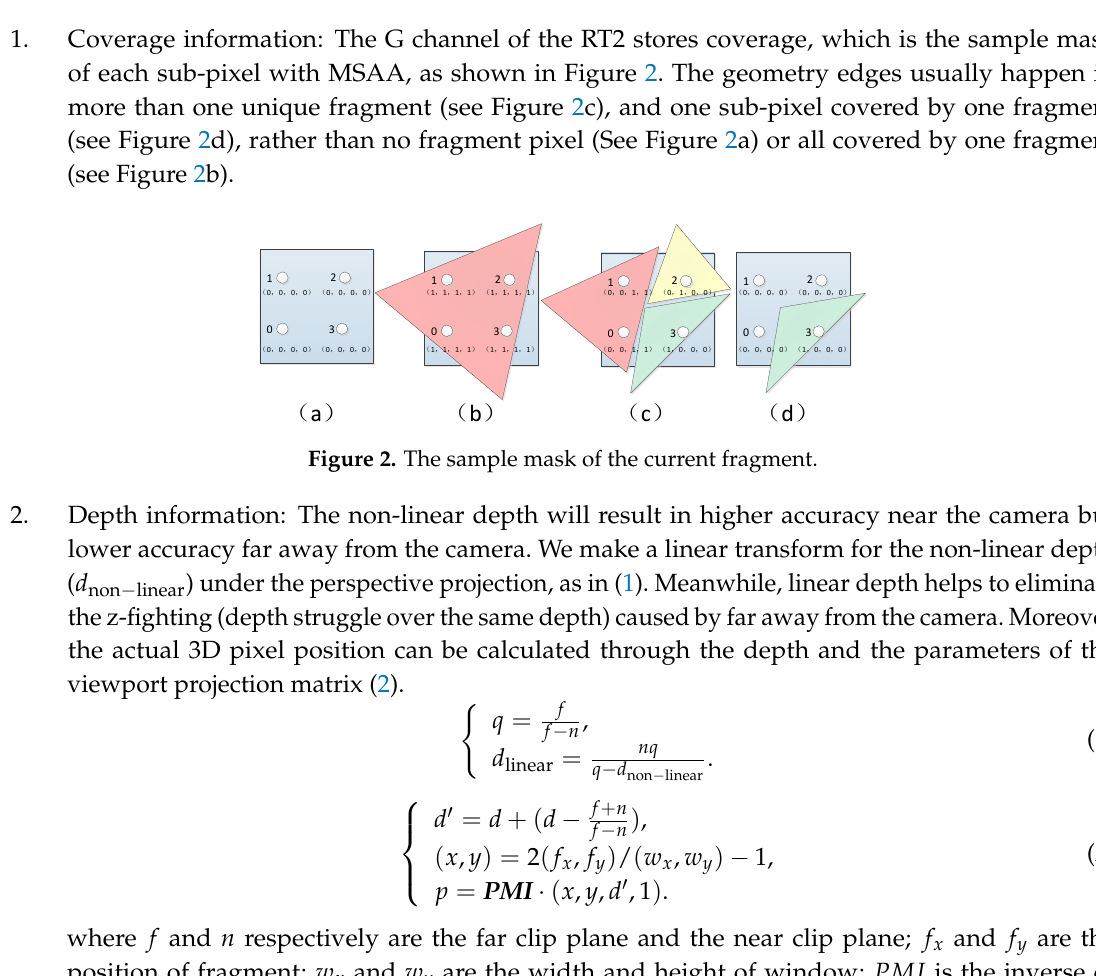
Table 1. G-Buffer information. Five render targets are used and four channels under each render target respectively store different geometry information. Render Target R Channel G Channel B Channel A Channel Color R Color G Color B Normal R Normal G Transparency mask Alpha Depth Coverage —– —–